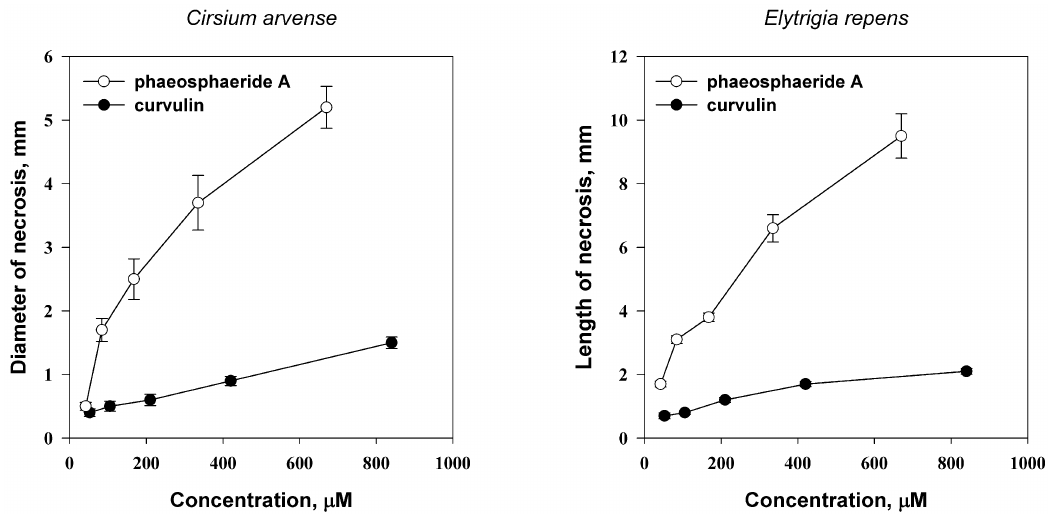
Figure 2. Phytotoxic activity of curvulin phaeosphaeride A for Cirsium arvense ( left ) and Elytrigia repens ( right ) in different concentrations. Bars indicate standard deviation at p = 0.05. Phytotoxic activity of phaeosphaeride A at 335 µ M concentration was not selective. Surprisingly, E. repens and Triticum aestivum (both from Poaceae family) were more sensitive to phaeosphaeride A than the host plant of the producing fungus, C. arvense (Figure 3). C. arvense and Pisum sativum were the most sensitive to curvulin at the concentration 840 µ M while other plant species were less susceptible to this toxin (Figure 3).